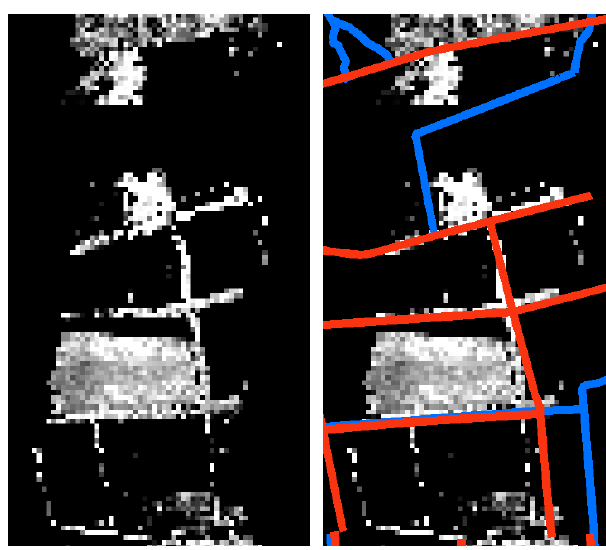
Figure 5 Abundance map for endmember 5 representing vegetation (left), overlayed with input GIS